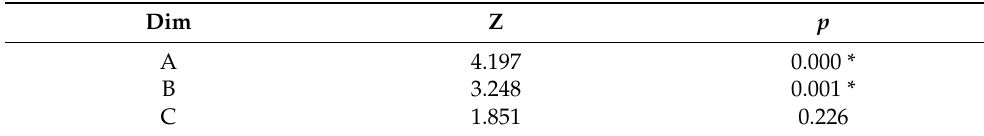
Table 4. Results of the Wilcoxon single-sample test. Dim